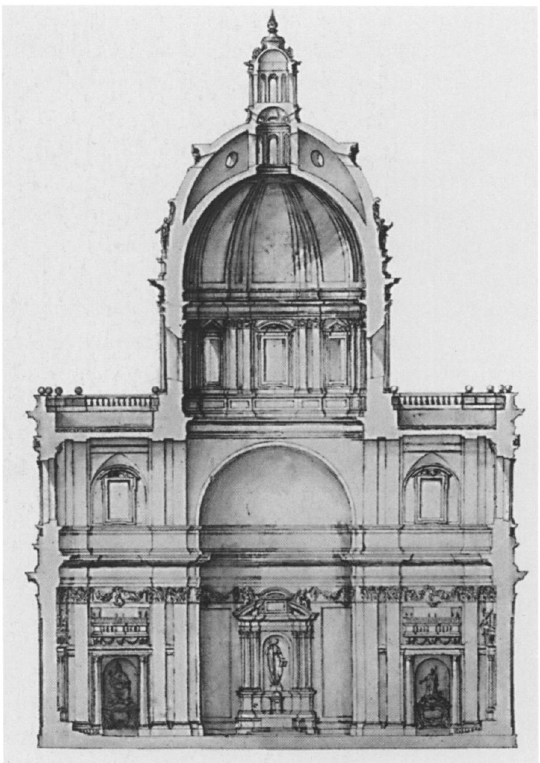
Figure 2. Orazio Grassi, Project for the dome of St Ignatius. (BAV—Chig.P.VII.9 f. 137 r). Copyrights and Credits: BAV Biblioteca Apostolica Vaticana, 2022.